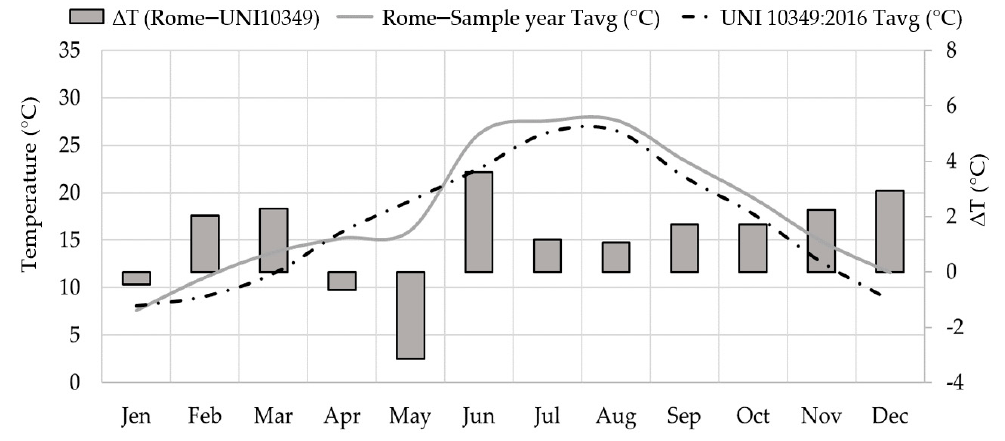
Figure 8. Sample year and UNI10349 temperature